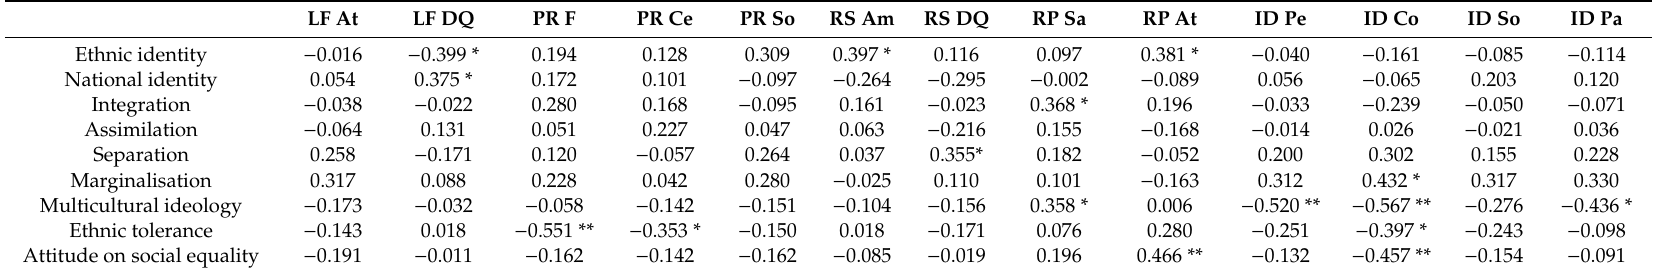
Table 4. The association of acculturation with subscales of five domains of CIYCFP ( n = 32).